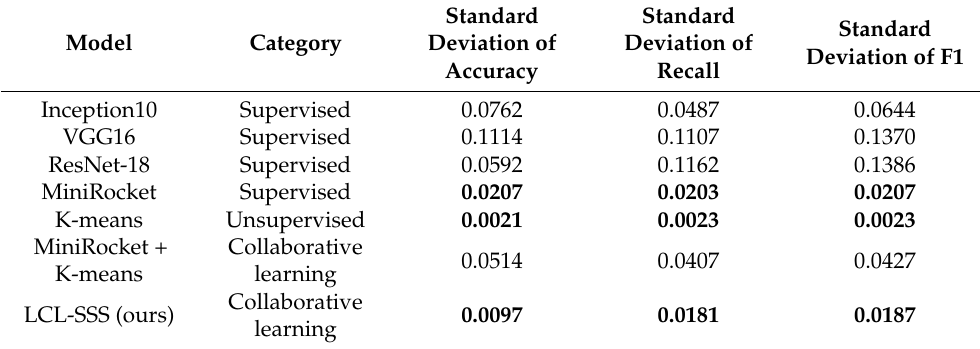
Table 3. Standard deviation of accuracy, recall, and F1